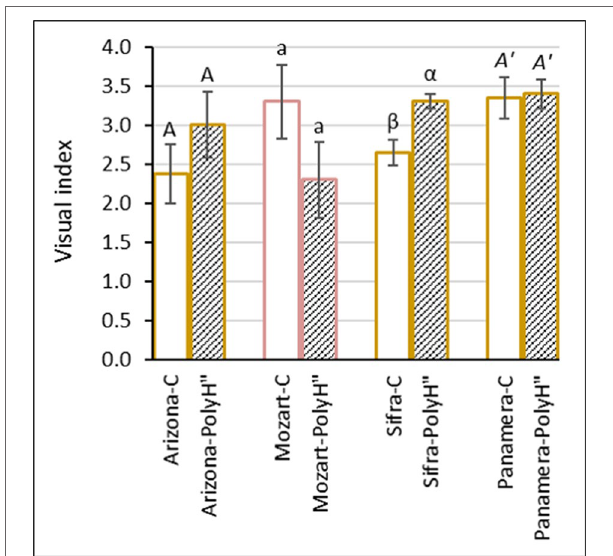
FIgURE 4 | Evaluation of skin appearance of the early variety Arizona (white skin), and the late varieties Mozart (red skin), Sifra, and Panamera (both white skin) (experiment 2). Potato plants were fertilized with polyhalite 2 days after haulm desiccation (PolyH"); control plants (C) were not fertilized. Tubers were examined after 1 month in storage. Visual index and assessment were as described in Figure 2 . Values are averages of five replicates. Data were analyzed for statistical significance by Student’s t -test for each cultivar separately. Different letters between the cultivar’s C and PolyH" samples indicate significantly different values ( P <